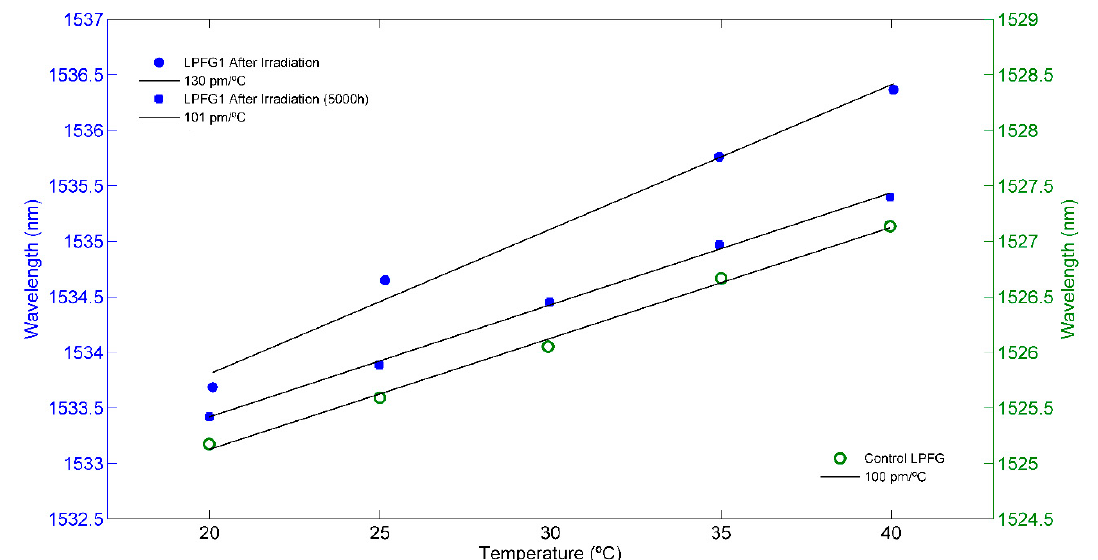
Figure 8. LPFG1 temperature sensitivity data (blue): after irradiation and after recovery (5000 h); Control LPFG temperature sensitivity data (green); linear fits are presented in black.